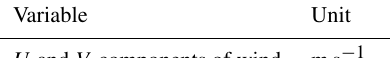
Figure 4. Bar graph showing the 2m temperature error distribu- tions for the COSMO-CLM (in blue) and WRF (in red) models, derived through comparison with available hourly station observa- tions (3344194 in